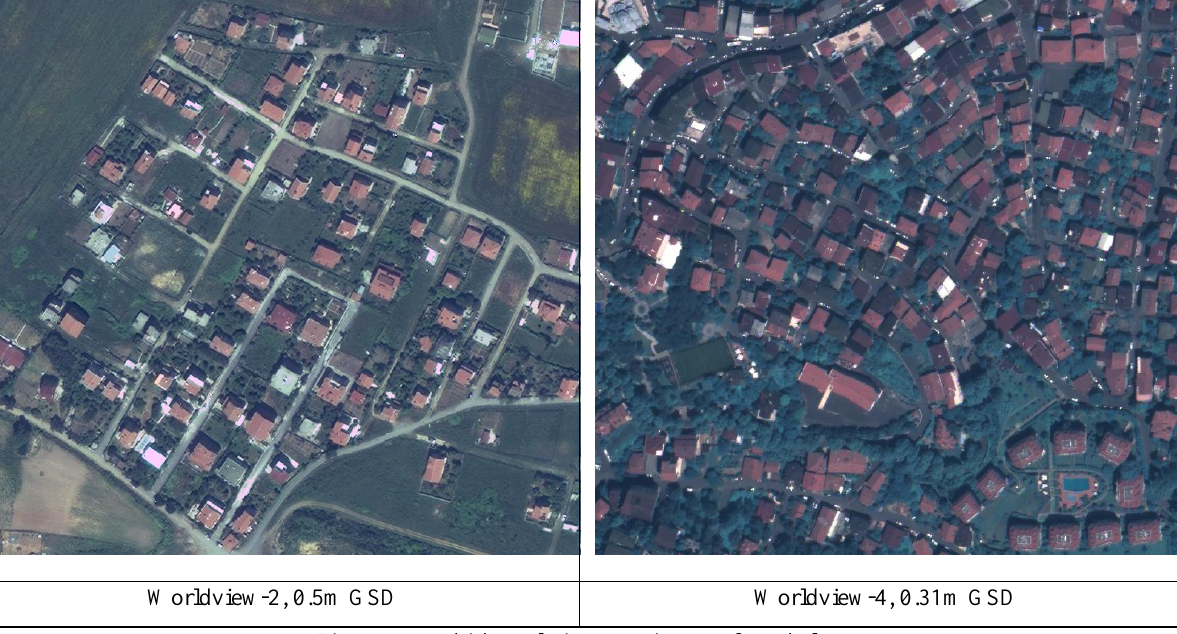
Figure 5. Very high resolution space images of Istanbul test area